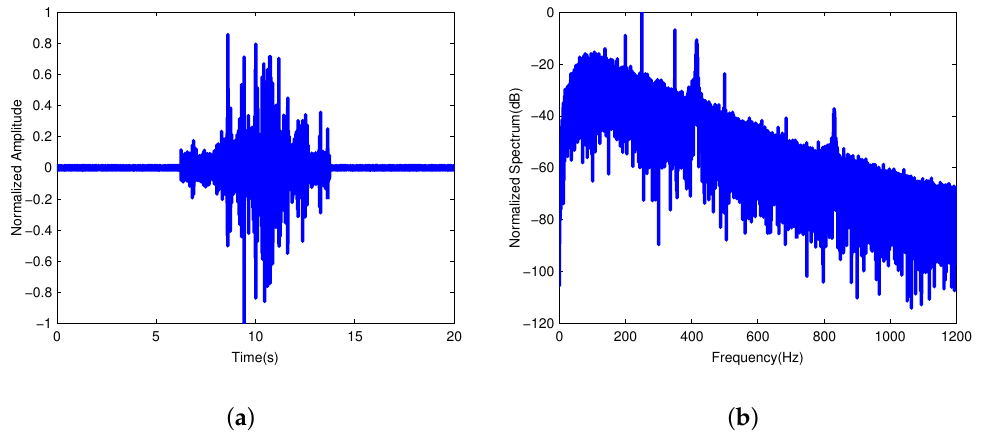
Figure 10. Reference signal of real-time experiment ( a ) time domain; ( b ) frequency